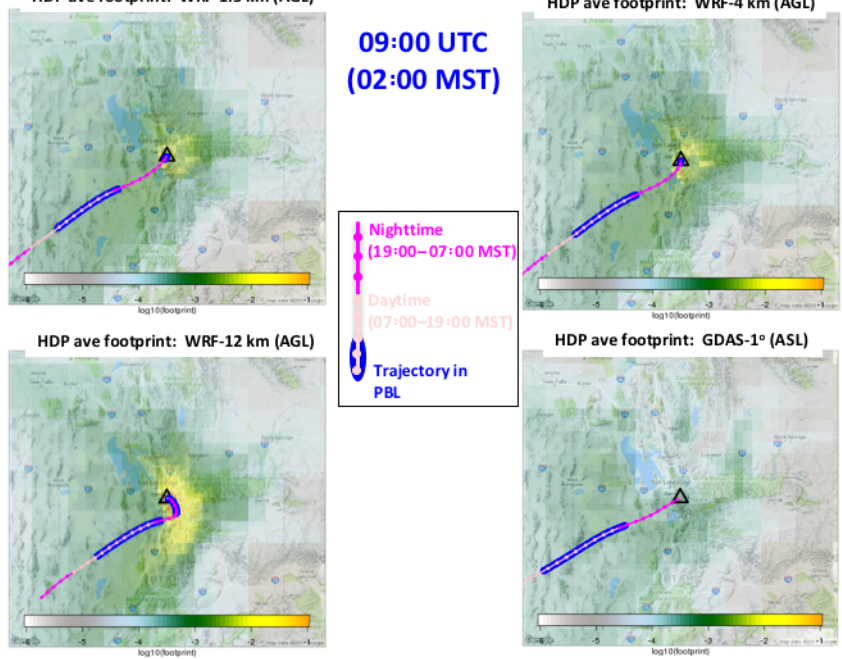
Figure 5. The average footprint (shown in log 10 ) for the Hidden Peak (HDP) site in Utah, at night: 02:00MST (09:00UTC), gridded at 0 . 1 ◦ × 0 . 1 ◦ . The site is denoted as a triangle. The average back trajectory (averaged over the stochastic STILT trajectories) is drawn as a line, with points indicating trajectory locations every hour, as the trajectory moves back from the site indicated as points. Magenta parts of the trajectory refer to the nighttime (19:00–07:00MST), while pink portions indicate the daytime (07:00–19:00MST). Parts of the trajectory are shaded with blue when it is found below the average height of the PBL along the